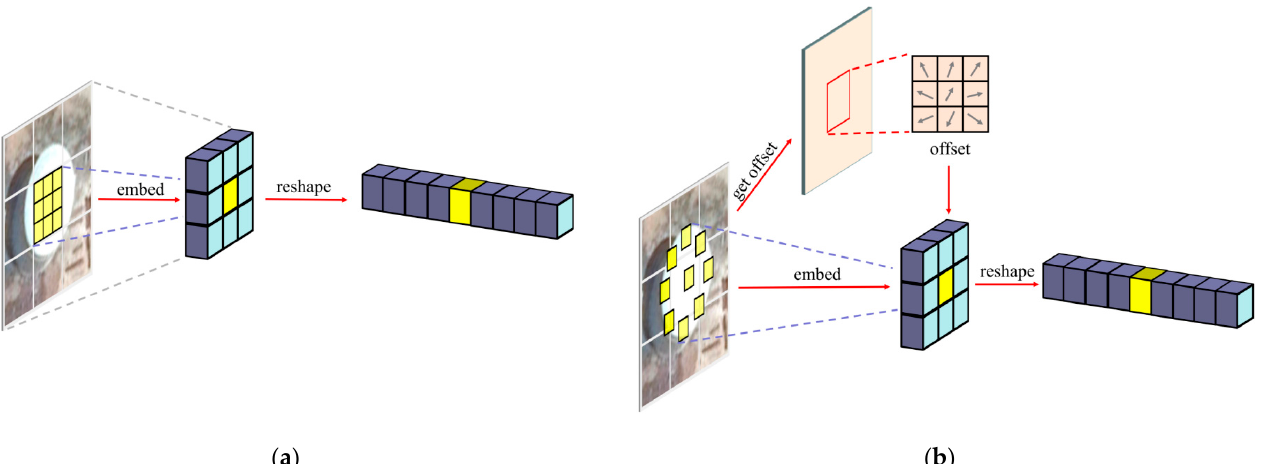
Figure 4. Comparison of vanilla patch embedding and deformable embedding: ( a ) vanilla patch embedding and ( b ) deformable embedding.